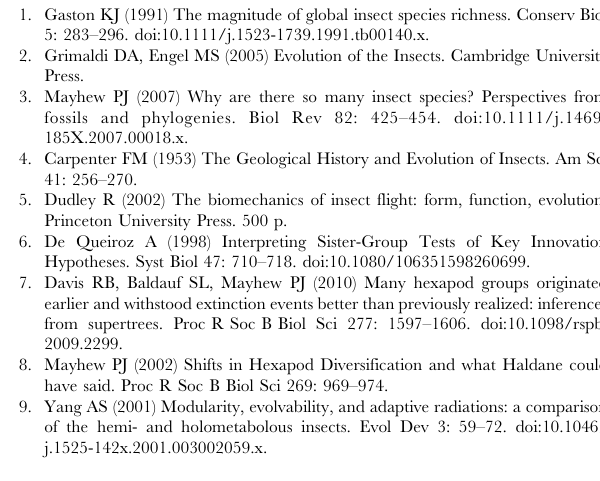
Table S3 Parameter values and shifts in species richness associated with MEDUSA model shifts inferred across the mean topology. Shifts listed here are plotted on Fig. 1. Richness shifts are plotted on Fig. 3. See text and Supplementary materials for further discussion. Table S4 The fifty most robustly recovered shifts inferred from 500 samples from the post-burnin Markov Chain Monte Carlo (MCMC). Shifts are plotted on Figure S3. Shifts without equivalents on the mean tree are highlighted in bold. (XLSX) Datafile S1 Tree topology in Nexus format. Contains two tree files with a) an undated cladogram including bootstrap support for nodes and b) a dated topology including confidence intervals for the node ages and denotation of inferred shift events matching Fig. 1. Datafile S2 Alignment and MrBayes instructions in Nexus format. Contains the implemented alignment after processing with the commands and priors used in setting the MrBayes dating run. Text S1 Supplementary Experimental Procedures and Discussion. Contains further details of experimental procedures, discussion of topology and reliability of diversification shift estimates, and cited references for fossil calibrations and species richness estimates (Table S1,